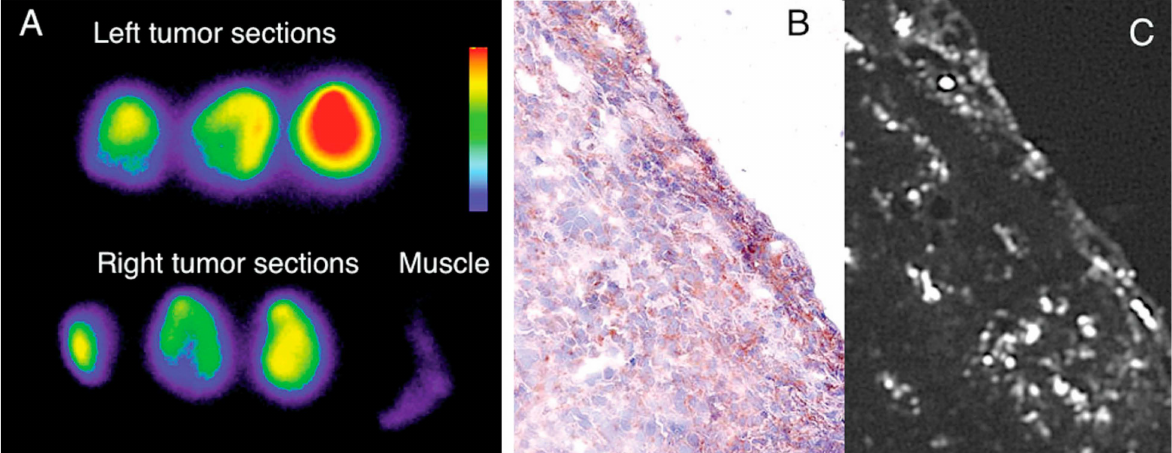
Figure 14. The study of DNP distribution using autoradiography and histopathology. Sections of tumor and adjacent normal tissue ( A ) autoradiographed to highlight predominant accumulations in malignancies. In ( B ), a typical Mac3 immunohistology specimen can be seen. The sections next to B show the distribution of fluorescent DNPs in Mac3-positive cells ( C )